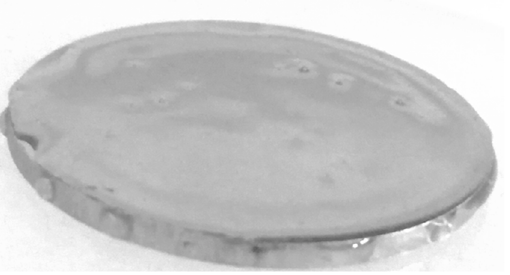
Figure 2. Photograph of the AISI 316L disk covered with the spin coated layer of (DCi + DPA).